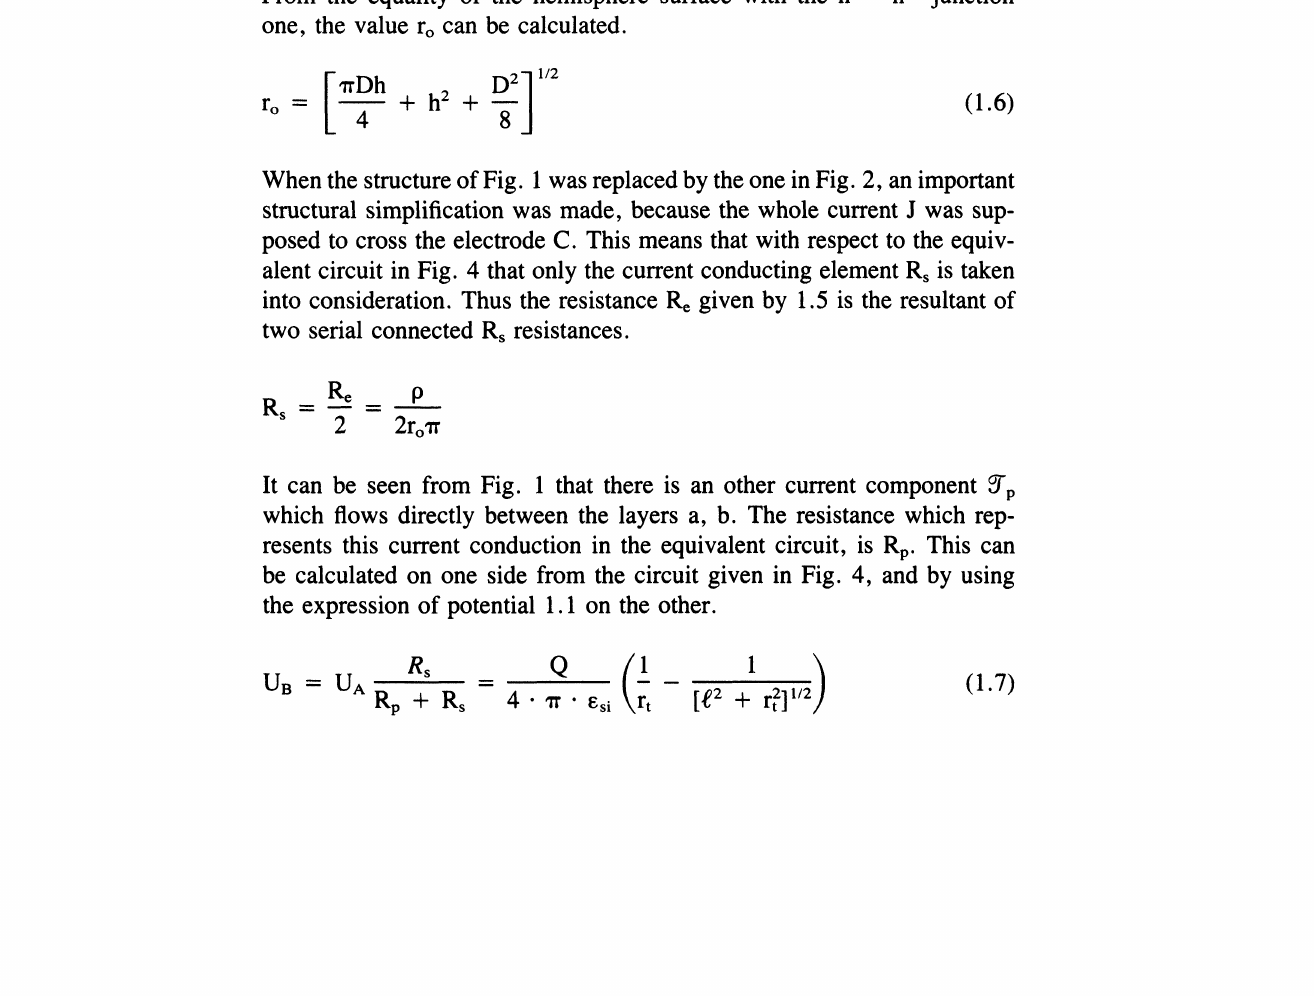
FIGURE 4 The equivalent